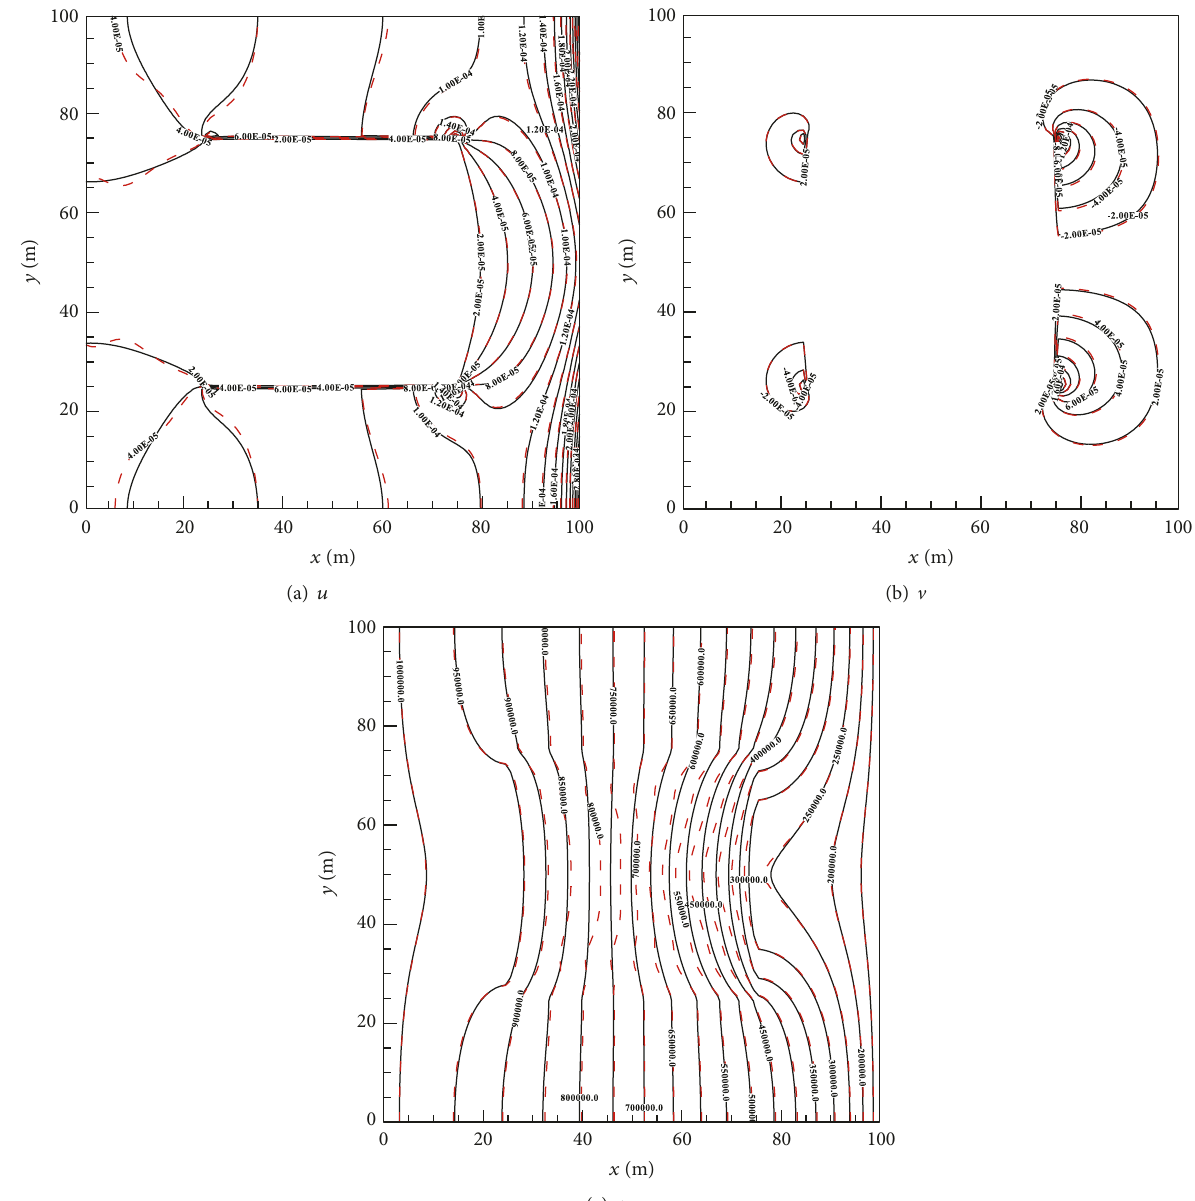
Figure 4: Flow field comparison for the minimum deviation. Black line: FDM; red dashed line: